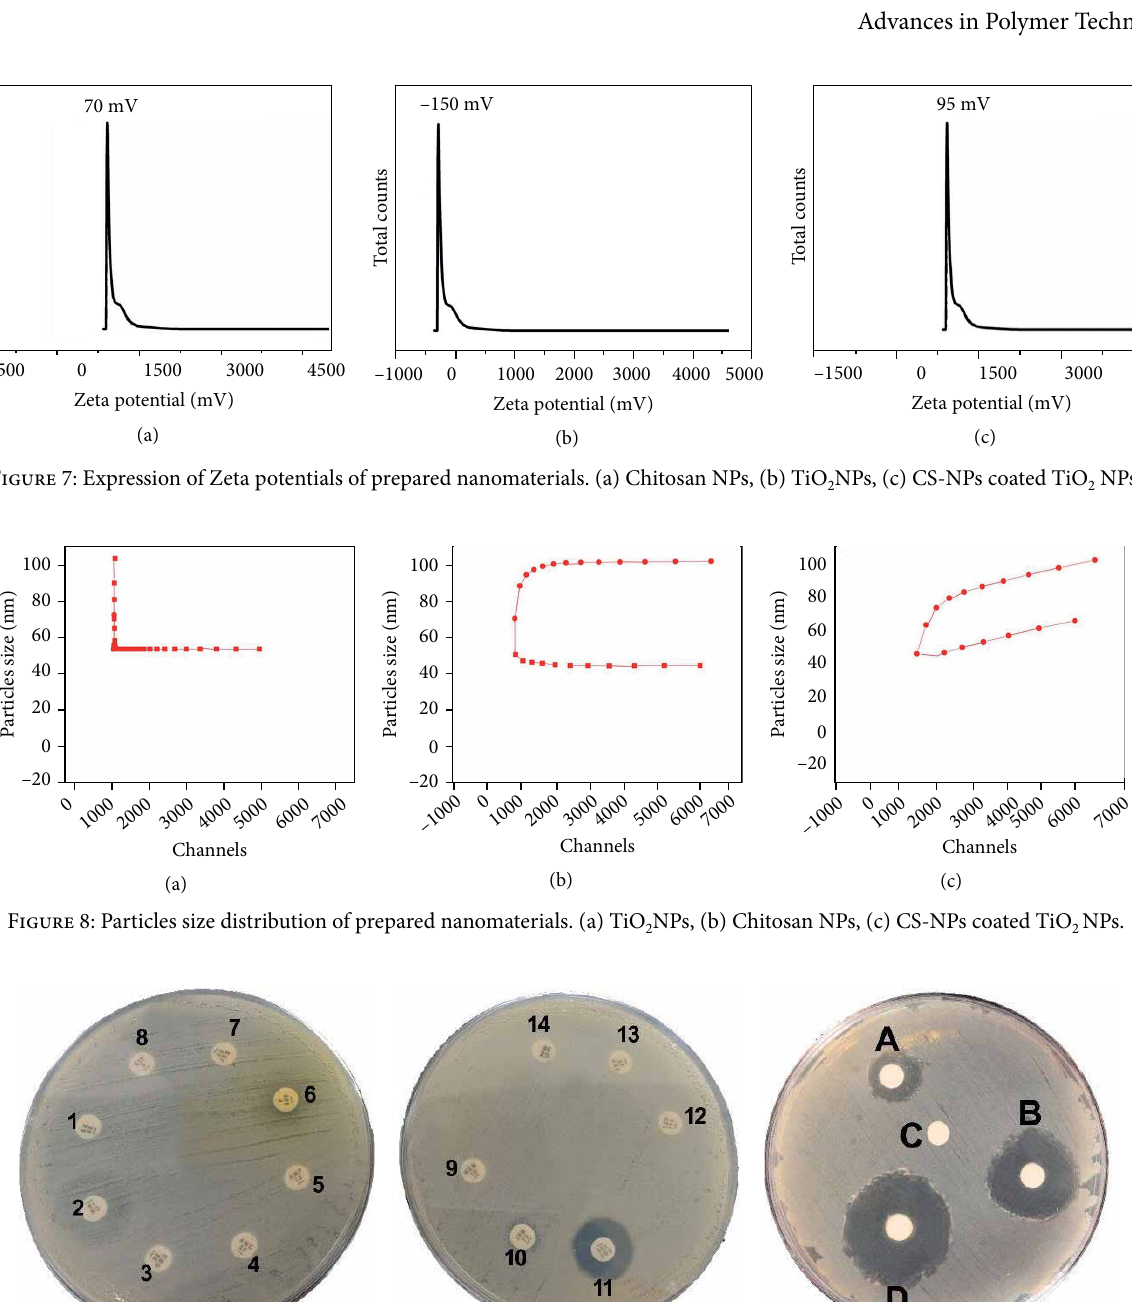
Figure 9: Antibiotic sensitivity profiling of isolated E. coli strain and antibacterial activity of synthesized nanoformulations. (a) and (b) different antibiotics discs: 1-AX, 2-CN, 3-CRO, 4-AMC, 5-AMP, 6-F, 7-SXT, 8-CIP, 9-MEM, 10-IPM, 11-FOT, 12-TZP, 13-FEP, 14-CZ, (c) Antibacterial activity of synthesized materials: A-chitosan NPs, B-TiO NPs, C-control, D-CS NPs coated TiO 2 2